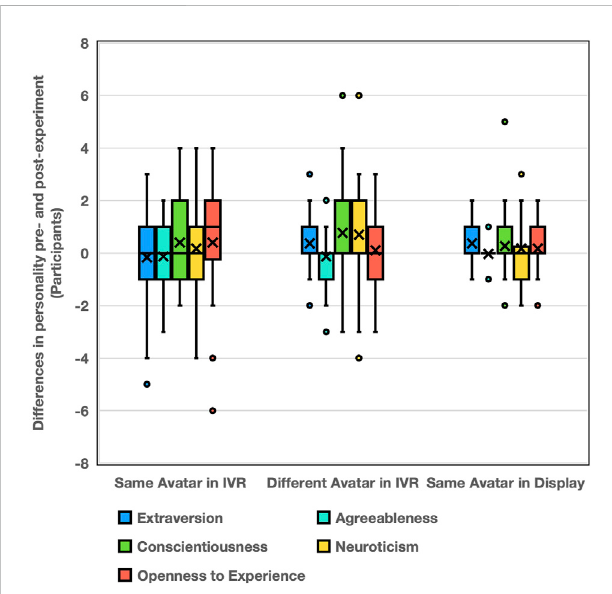
FIGURE 2 Differencesinparticipant ’ spersonality pre- and post-role-play (G1: Same Avatar in IVR, G2: Different Avatar in IVR, G3: Same Avatar in 2D). The bars denote the quartile point.